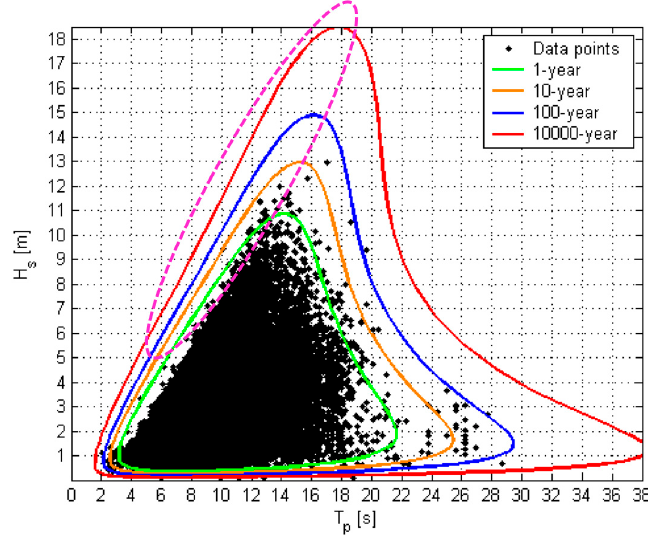
Figure 1. Environmental contour lines for the northern North Sea, including an indication of critical area for wave impact. Based on figure in [8].